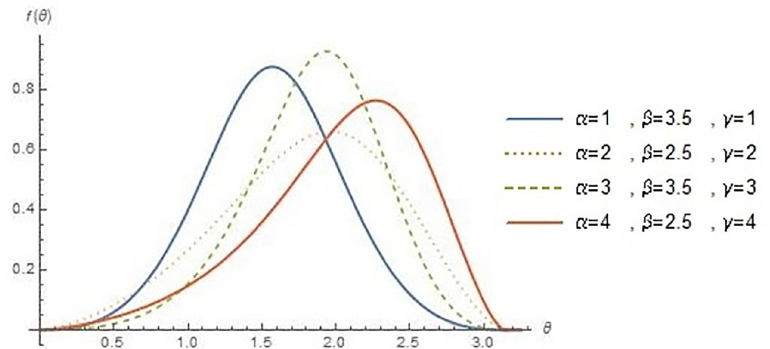
Fig 1. Linear presentation of hcMB − III density.